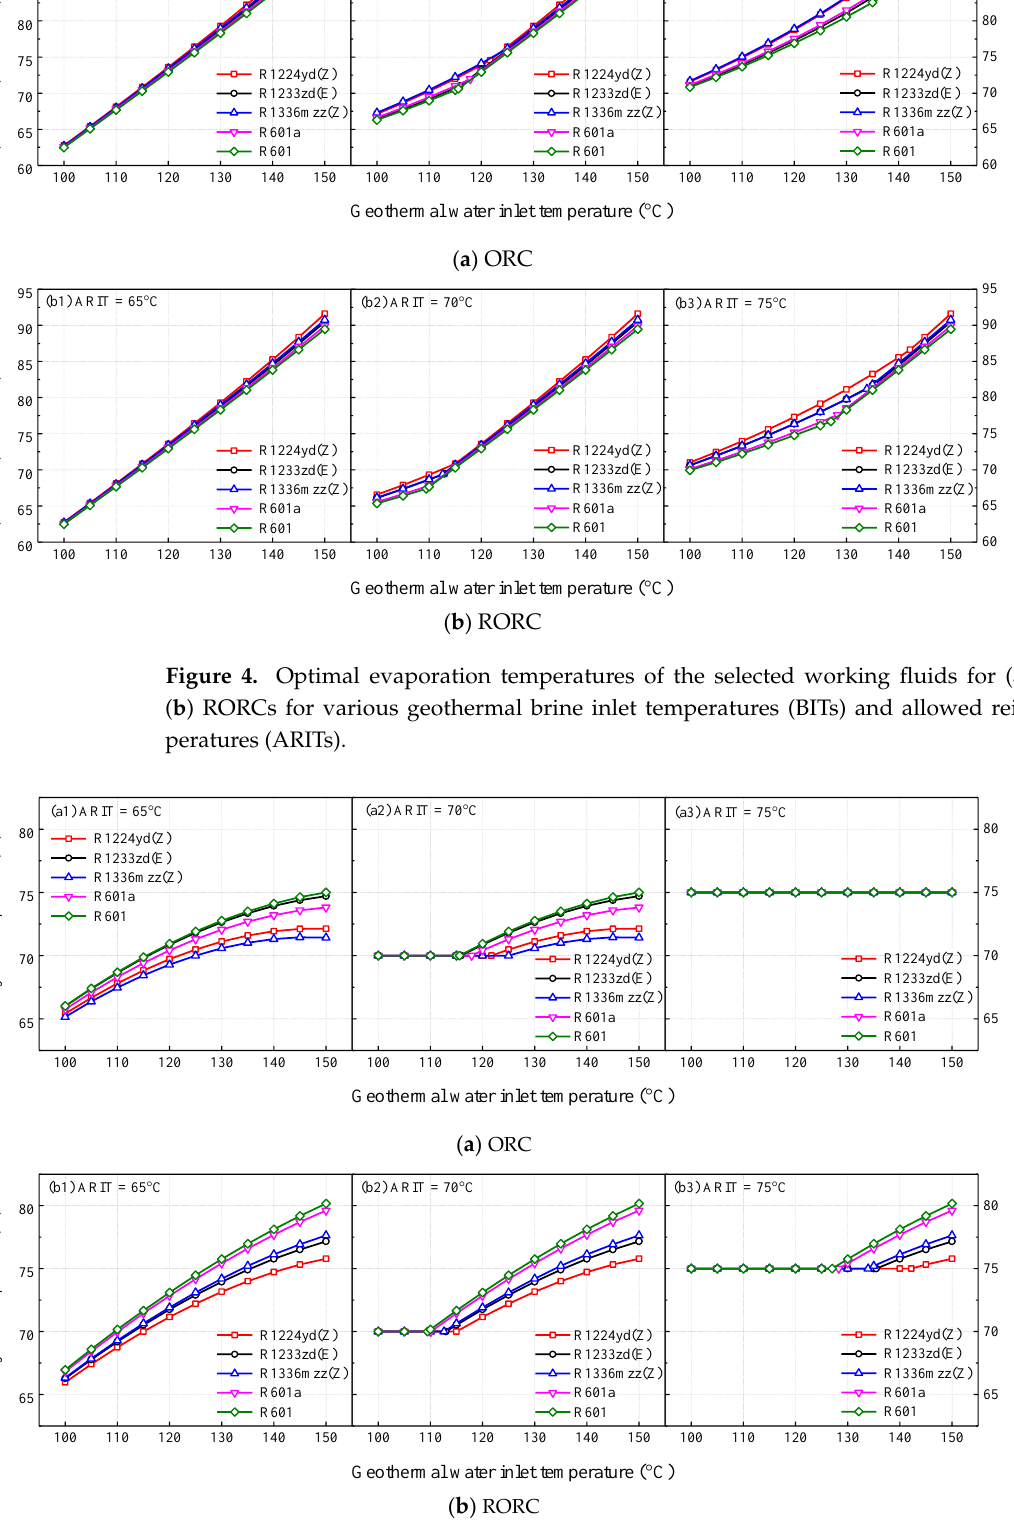
Figure 5. Reinjection temperatures at the optimal conditions for ( a ) ORCs and ( b ) RORCs. A recuperator recovers part of the waste heat from the turbine exhaust and then in- creases the preheater inlet temperature that leads to a decrease in cold source losses and an increase in the cycle thermal efficiency. The working fluid temperature increase through the recuperator increases with increasing BIT, since the turbine exhaust temper- ature also increases. The use of a recuperator does not affect the optimal evaporation tem- perature for an ARIT of 65 °C, as shown in Figure 4(b1), but the reinjection temperature at the optimal condition of a RORC is higher than that of an ORC, as shown in Figure 5(b1). The turbine exhaust temperature of R1233zd(E) is much lower due to the near-ver- tical slope of the saturated vapor curve as seen in Figure 3, which leads to a smaller tem- perature rise in the recuperator; thus, the increase in the reinjection temperature by a re- cuperator with R1233zd(E) is the lowest among the five working fluids, which ranges from 0.3 °C to 2.5 °C. The temperature increases of R1336mzz(Z), R601a and R601 in the recuperator are 4.9 – 5.3 °C for a BIT of 100 °C and 13.2 – 14 °C for a BIT of 150 °C with an ARIT of 65 °C, because of their higher turbine exhaust temperatures. The preheating load for R1336mzz(Z) is higher than R601a and R601 due to the lower latent heat of vaporiza- tion for a given evaporation temperature. Therefore, the increase in the reinjection tem- perature by a RORC with R1336mzz(Z) is slightly higher than that with R601a or R601. RORC increases the reinjection temperature by 1.2 – 6.2 °C with R1336mzz(Z) and 0.9 – 5.2 °C with R601. The reinjection temperatures of RORCs using R1336mzz(Z), R601a and R601 are higher than that using R1233zd(E), as shown in Figure 5b. The optimal evaporation temperature of RORC is lower than that of an ORC due to the pinch temperature difference limit for a BIT less than around 115 °C and an ARIT of 70 °C. The decrease in the evaporation temperature recovers the benefit of the increasing cycle efficiency caused by a recuperator. However, the working fluid mass flow rate is increased due to the higher preheater inlet temperature and the slightly lower evaporation